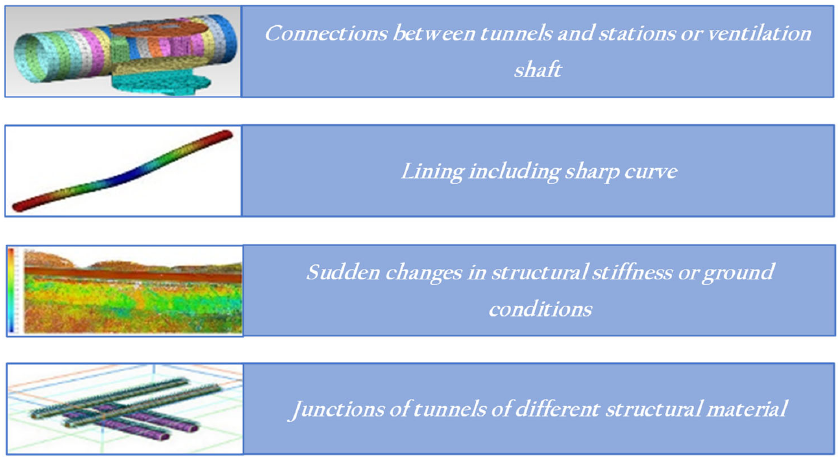
Figure 3. Conditions for studying the effects of earthquakes.